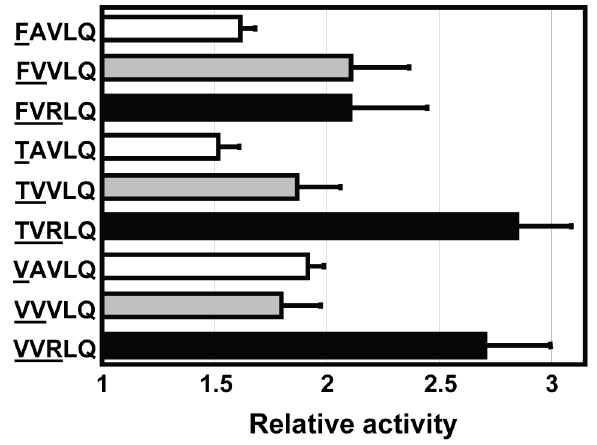
Figure 5. Super-active substrates were created by combining the best residues at P5 to P1 positions. Three variants with double- substitution (grey bar) and three variants with triple-substitution (solid bar) were created,andtheir relativeactivities were measured.Therelative activities of FVVLQ Q SGF, TVVLQ Q SGF, VVVLQ Q SGF, FVRLQ Q SGF, TVRLQ Q SGF and VVRLQ Q SGF were 2.11 6 0.26, 1.87 6 0.19, 1.80 6 0.17, 2.10 6 0.34, 2.84 6 0.25 and 2.71 6 0.29, respectively.